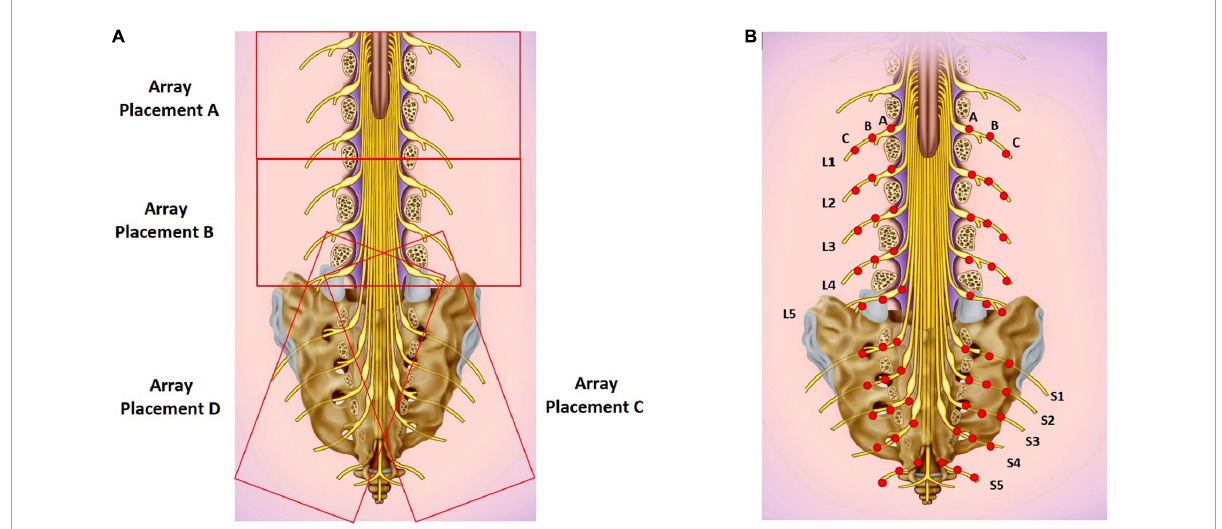
FIGURE1 (A) LED array placements A, B, C, and D. (B) Target areas for laser probe stimulation marked as red dots. Each point is stimulated for 20 seconds. Basic image obtained from dreamstime.com with permission.